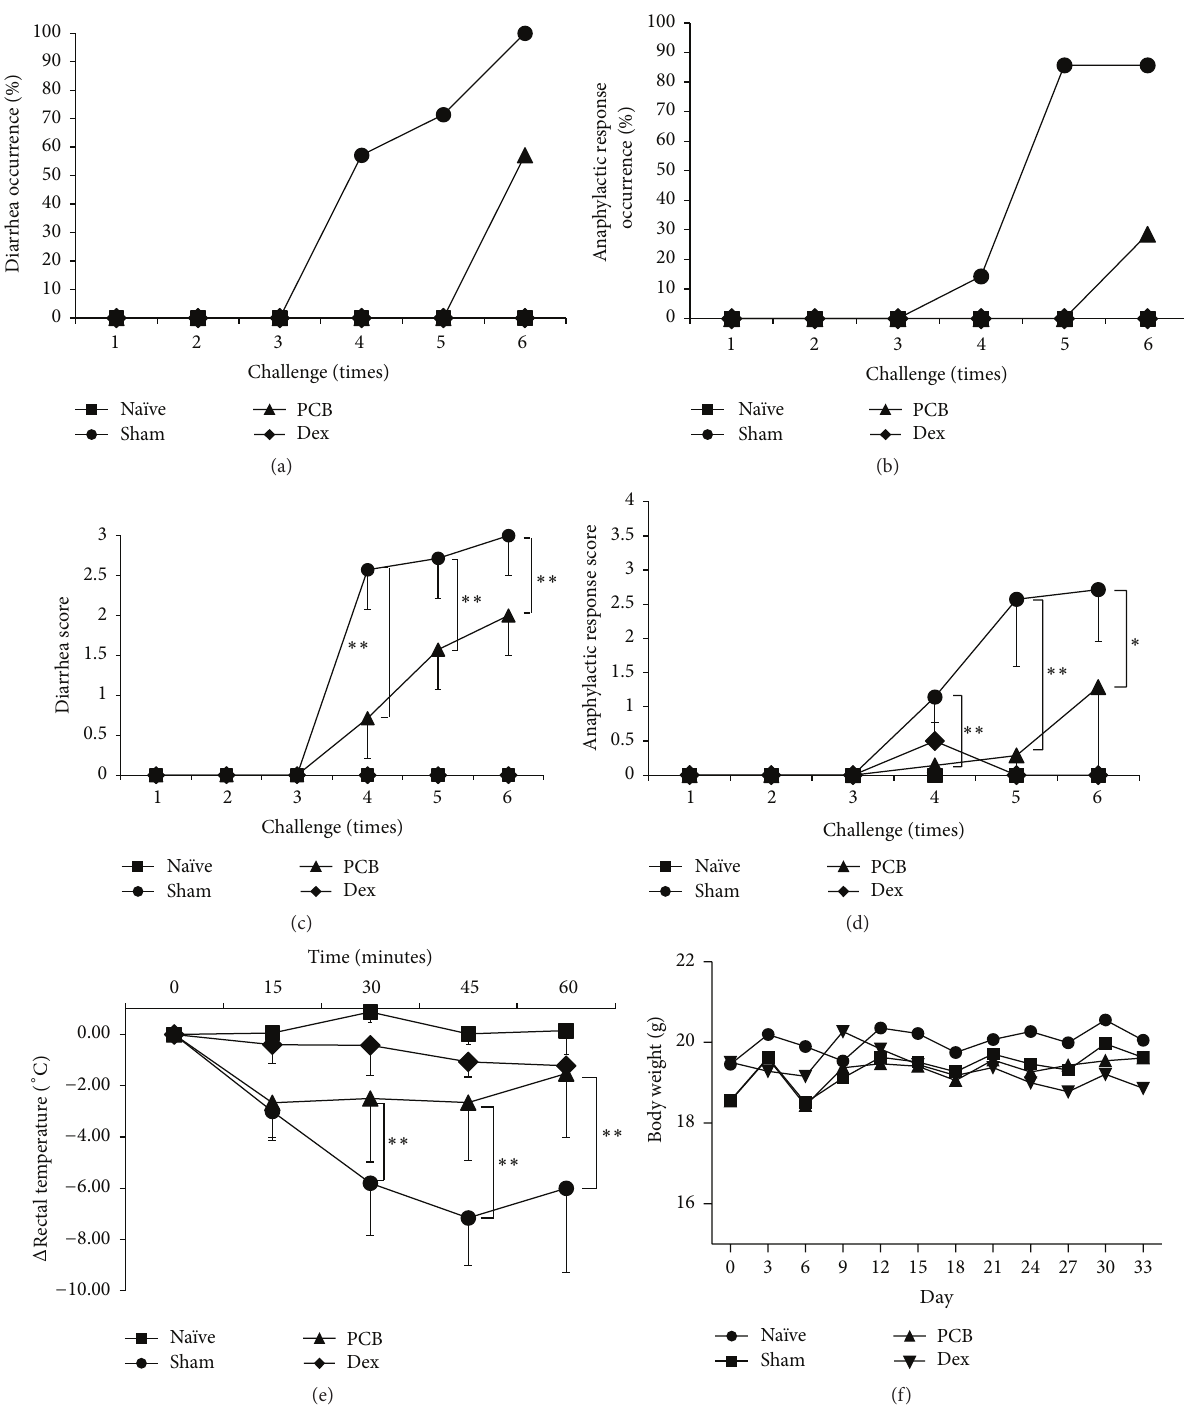
Figure 4: Effect of PCB extract on ovalbumin-induced diarrhea, anaphylactic response, and rectal temperature. OVA-induced food allergic symptoms were evaluated and scored by criteria for diarrhea and the anaphylactic response for 1h after challenge with OVA. The diarrhea score (a), diarrhea occurrence (%, score ≥ 2) (c), anaphylactic response score (b), and anaphylactic response occurrence (%, score ≥ 2) (d) were evaluated on all challenges. (e) Rectal temperature was measured every 15 min for 1h after the sixth OVA challenge. (f) Body weight during experiments. Data are presented as mean ± SD. Bars represent significant differences from the sham group at ∗ 𝑃 < 0.05 and ∗∗ 𝑃 < 0.01 versus sham. Data were analyzed using one-way repeated measures of ANOVA followed by Dunnett’s post hoc